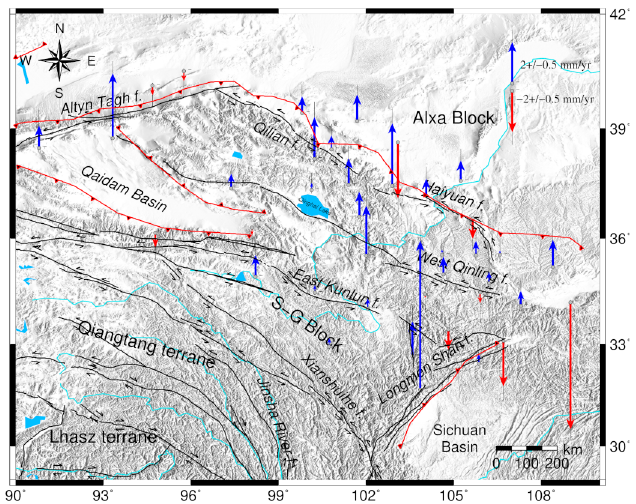
Figure 8. The CGPS-derived vertical velocity field relative to ITRF 2014 in NET Tibet; the blue vectors denote uplift, and the red vectors denote subsidence; the thin black vertical lines are the